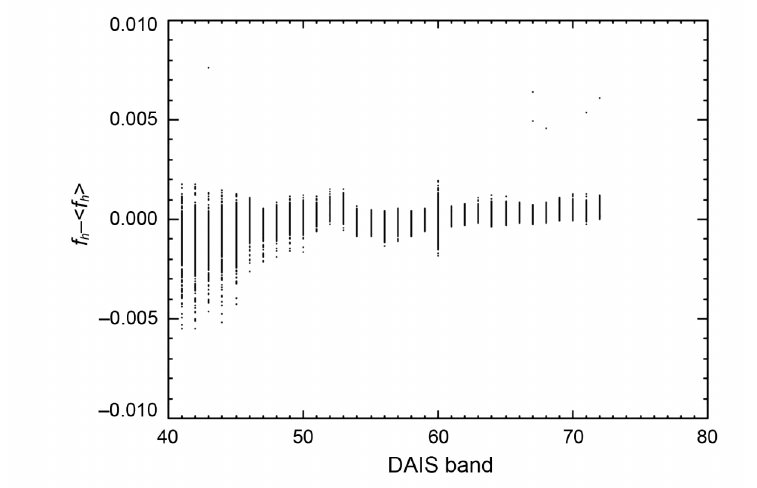
Fig. 4. f h −< f h > deviation: < f h > is calculated for each